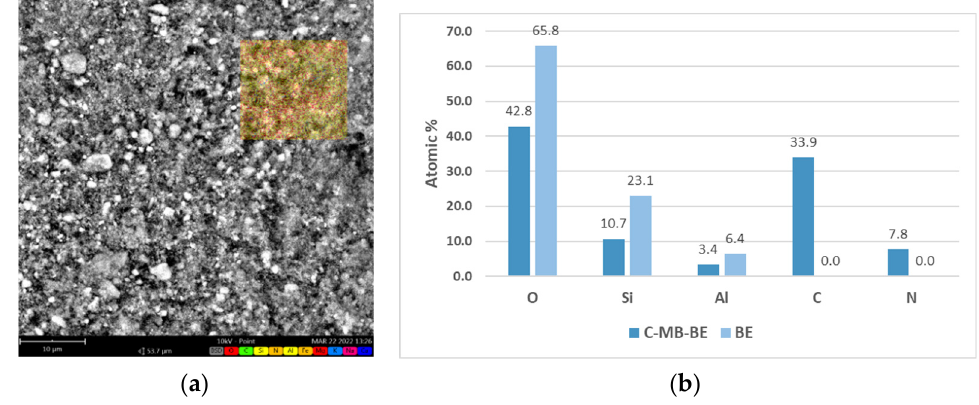
Figure 4. EDX map ( a ) and elemental composition change for carbonized MB-saturated bentonite (C-MB@BE) in comparison to pristine bentonite (BE) sample ( b ).